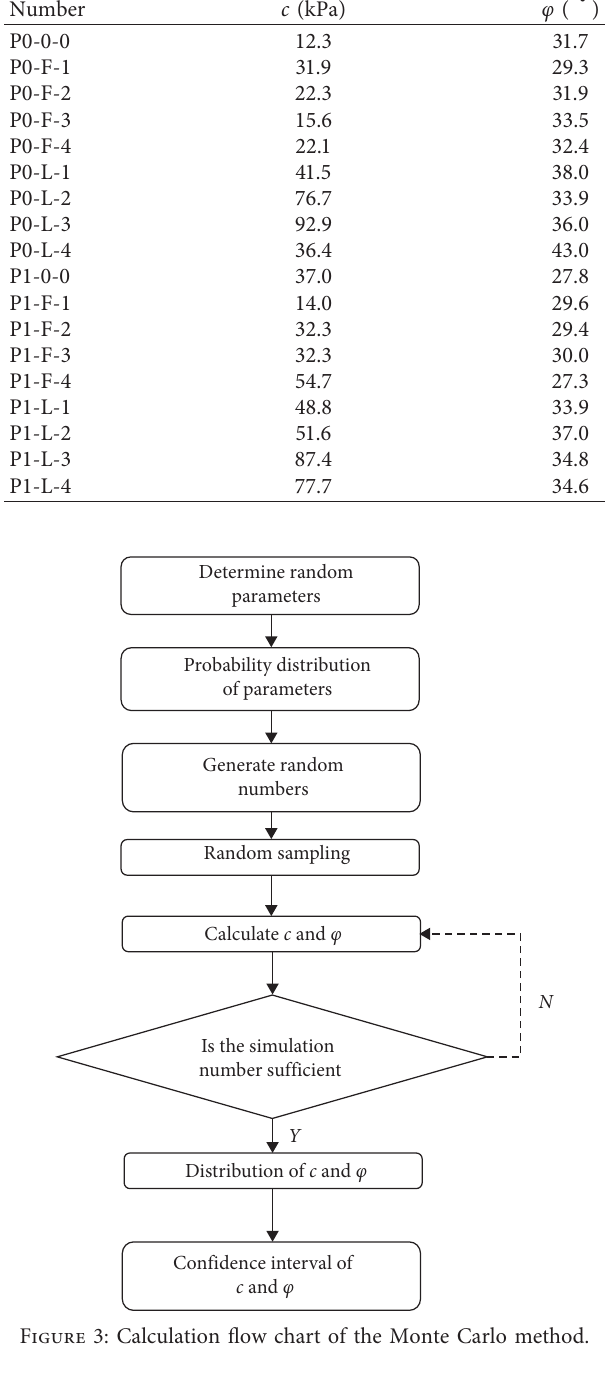
Table 2: c and φ values of each group of samples.